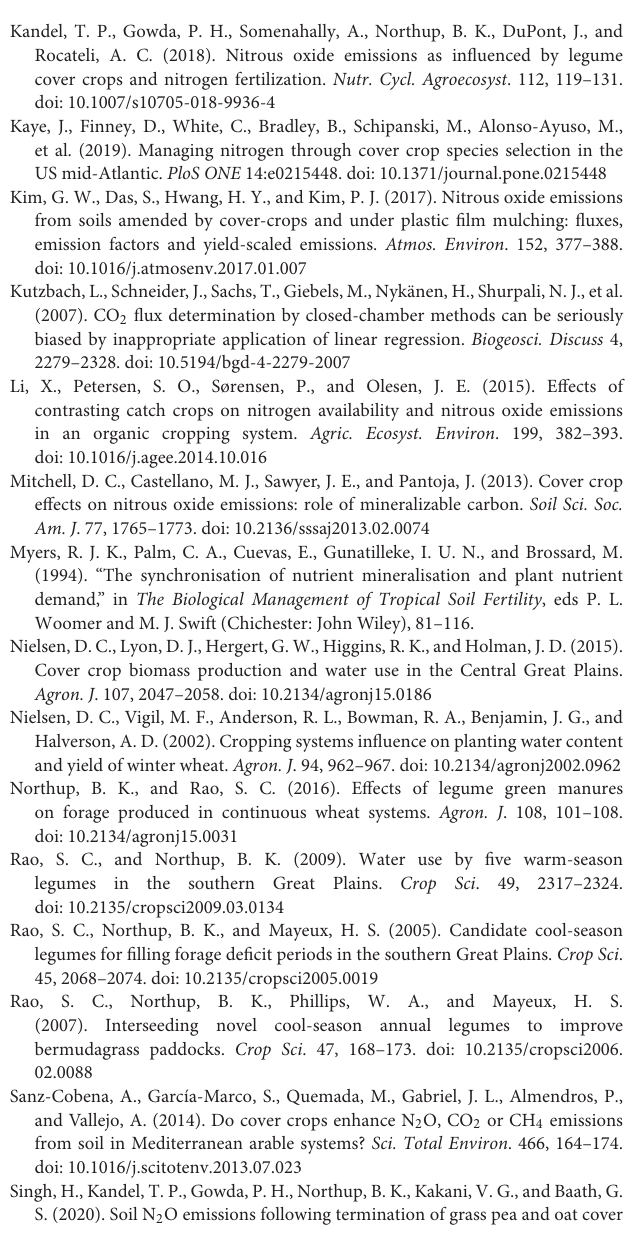
Supplementary Figure 1 | (a) Average long-term and study year air temperature for the months of May, June, July, and August. (b) Average long-term and study year precipitation for the months of May, June, July, and August. Supplementary Figure 2 | Correlation matrices with Pearson’s correlation coefficients (R) of nitrous oxide (N 2 O) emissions and soil variables on 25 measurement dates during the study period. EC, electrical